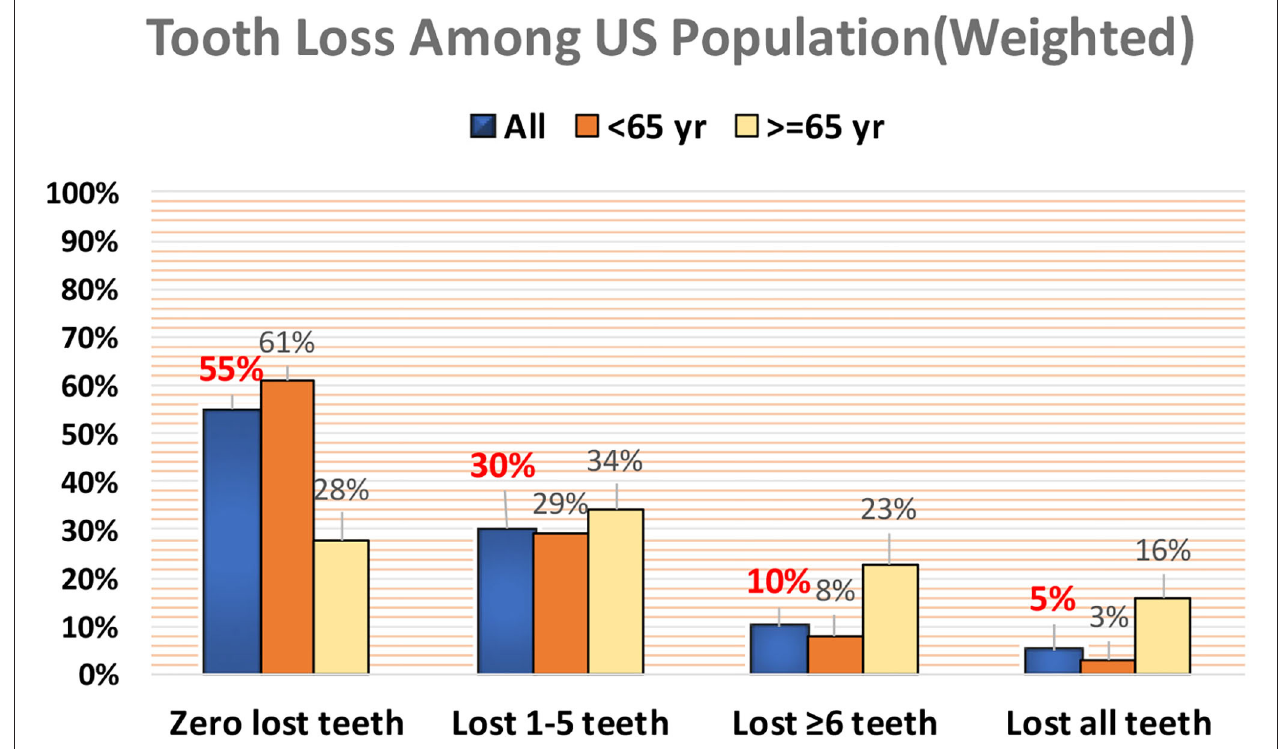
FIGURE 1 | Weighted prevalence of tooth loss among US